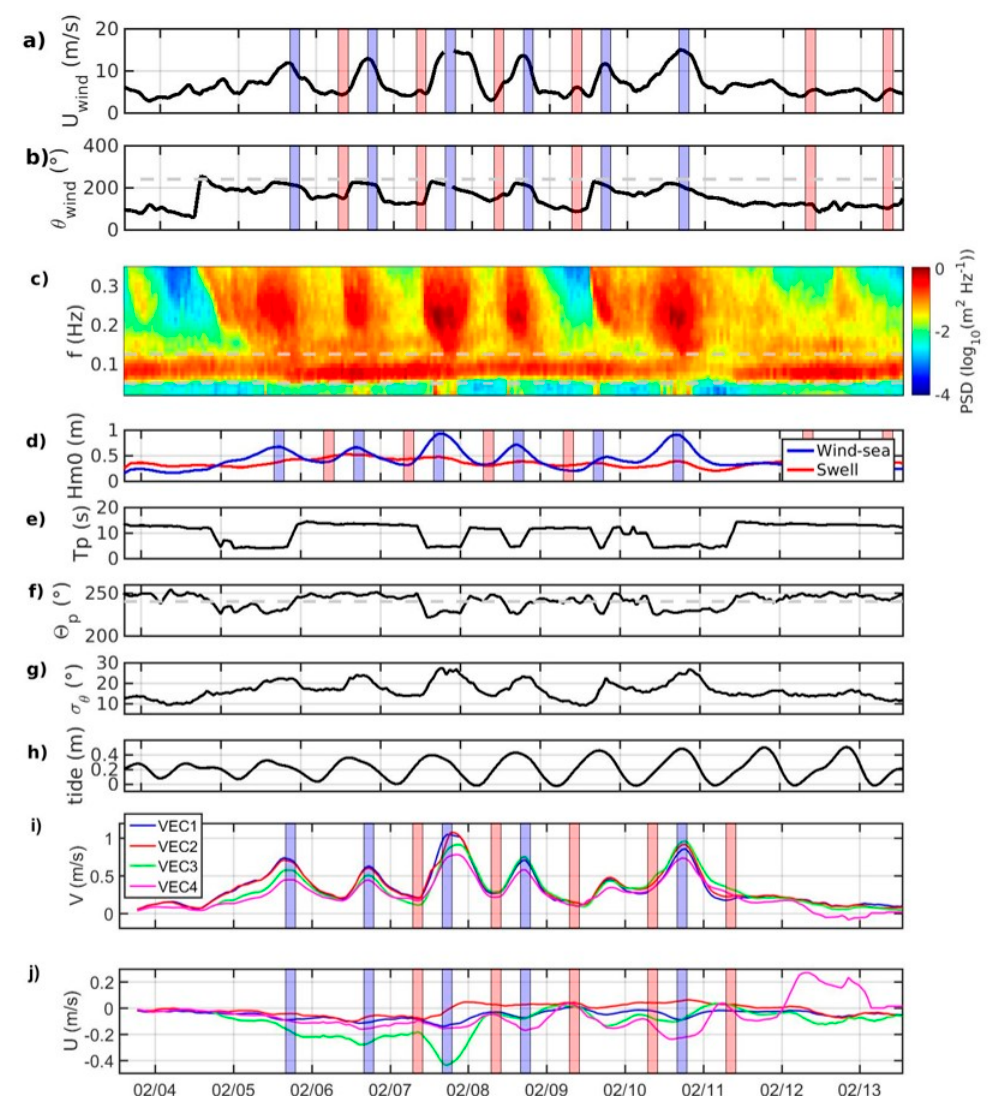
Figure 4. Time series of ( a ) wind speed and ( b ) wind direction (The horizontal gray dashed line indicates the direction normal to the beach. Direction is in nautical convention.) measured at the anemometer. Direction is in nautical convention. ( c ) Spectrogram of elevation measured at the AWAC Acoustic Surface Tracking (AST) (The horizontal gray dashed line indicates the limits between infragravity (IG), swell and sea waves), time series of ( d ) wave height, ( e ) peak period, ( f ) peak direction (The horizontal gray dashed line indicates the direction normal to the beach. Direction is in nautical convention.), ( g ) directional spreading (smoothed over three hours), ( h ) hourly tidal level, ( i ) alongshore current velocity (positive northward), ( j ) cross-shore current velocity (positive seaward). Data are smoothed over three hours. The periods studied are represented with blue (wind-sea cases) and red (swell cases)